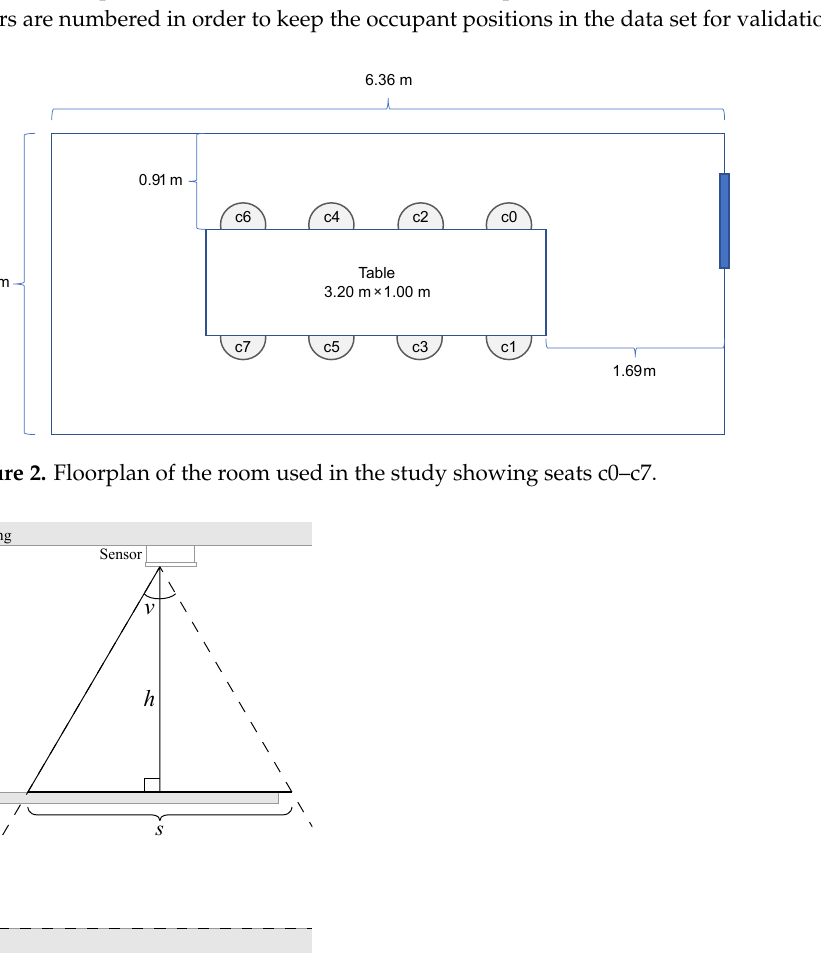
Figure 3. Side view of the room, showing the relationship between field of view, height to the table, and viewing